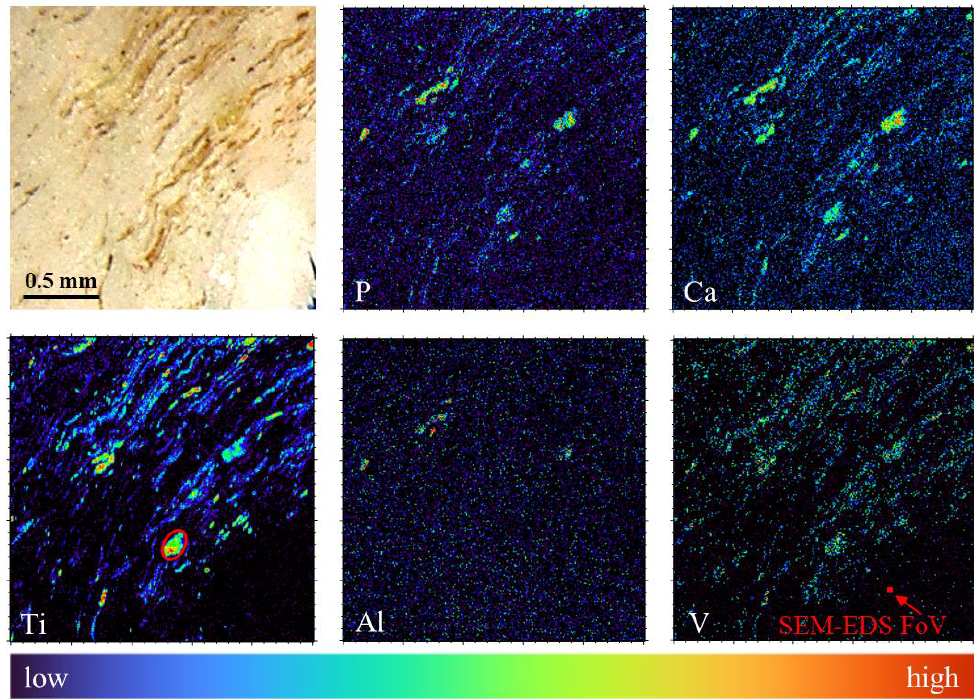
Figure 6. Qualitative elemental characterization of wear debris in periprosthetic tissue using micro-PIXE. Stereoscopic microphotograph (first image) and micro-PIXE elemental maps of P, Ca, Ti, Al and V in the scanned area (2 × 2 mm 2 ). Red oval inserted in the Ti elemental map shows the particle selected for quantitative analysis. Red filled square in the V elemental map shows 30 × 30 µm 2 field-of-view of the SEM-EDS analysis.